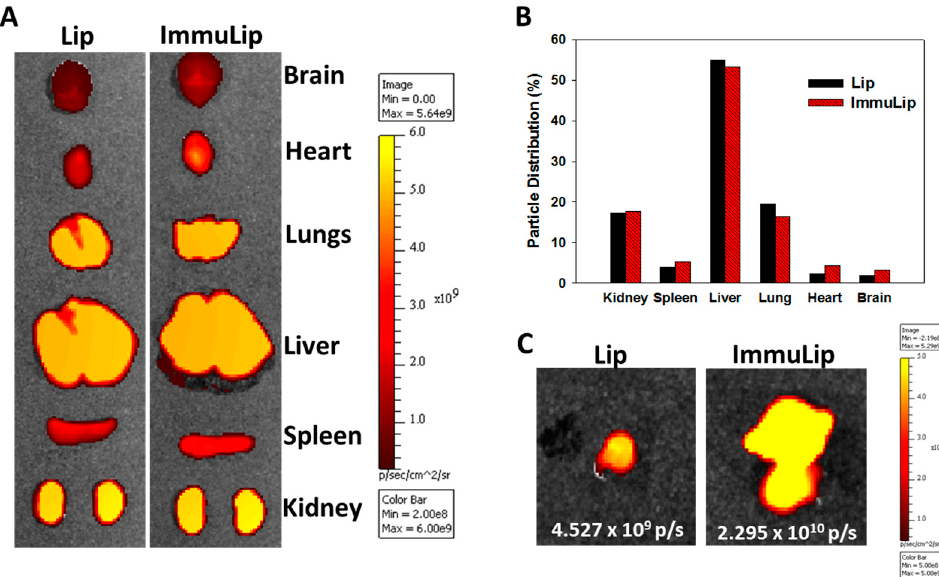
Figure 9. The biodistribution of Lip and ImmuLip in U87 tumor-bearing nude mice by injecting 100 µ L solution containing Cy5.5 labelled liposomes (2 mg / mL) through the tail vein. The in vivo imaging system (IVIS) was used for ex vivo imaging of harvested organs after 4 h ( A ) and quantification of distribution of liposomes in each organ was calculated based on fluorescence intensity in each organ ( B ). The targeting effects of ImmuLip vs Lip was shown from the ex vivo IVIS imaging of explanted tumors ( C ).